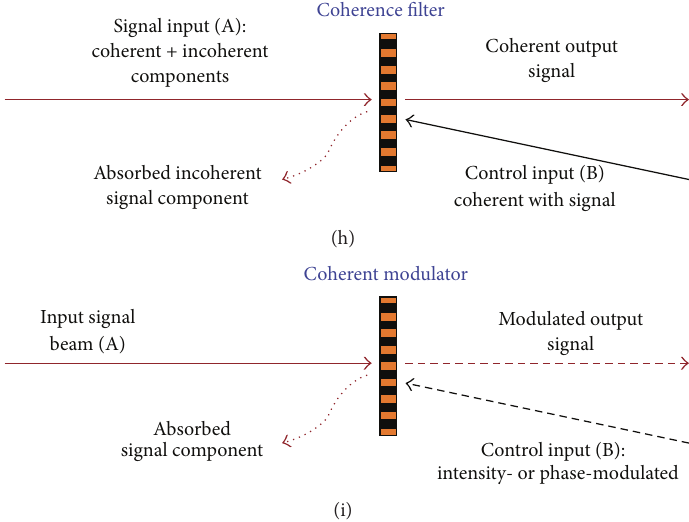
Figure 19: (a) Schematic of the coherent perfect absorber. (b) Absorption as a function of the frequency and the thickness of the doped silicon film. (c) Coherent absorption of a 450 nm thick doped silicon film. Red and green solid lines show the absorption for Δ𝑙 equal to 500 and 505.56 𝜇 m, respectively. (d) Coherent absorption of 17nm thick tungsten for symmetrical and antisymmetrical inputs. (e) Schematic of plasmon hybridization and the effective medium description. For the symmetrical (antisymmetrical) resonance, the external 𝐸 -fields ( 𝐻 -fields) should be parallel. (f) Coherent absorption of antisymmetrical inputs for TE polarization at oblique incidences. The inset of (f) illustrates the configuration of two coherent divergent beams with antisymmetrical phase distribution, where 𝜃 is the divergent angle. Figures are reproduced from [38, 123]. (g)–(i) Proposed applications of metasurface CPA in signal processing. Figures are reproduced from